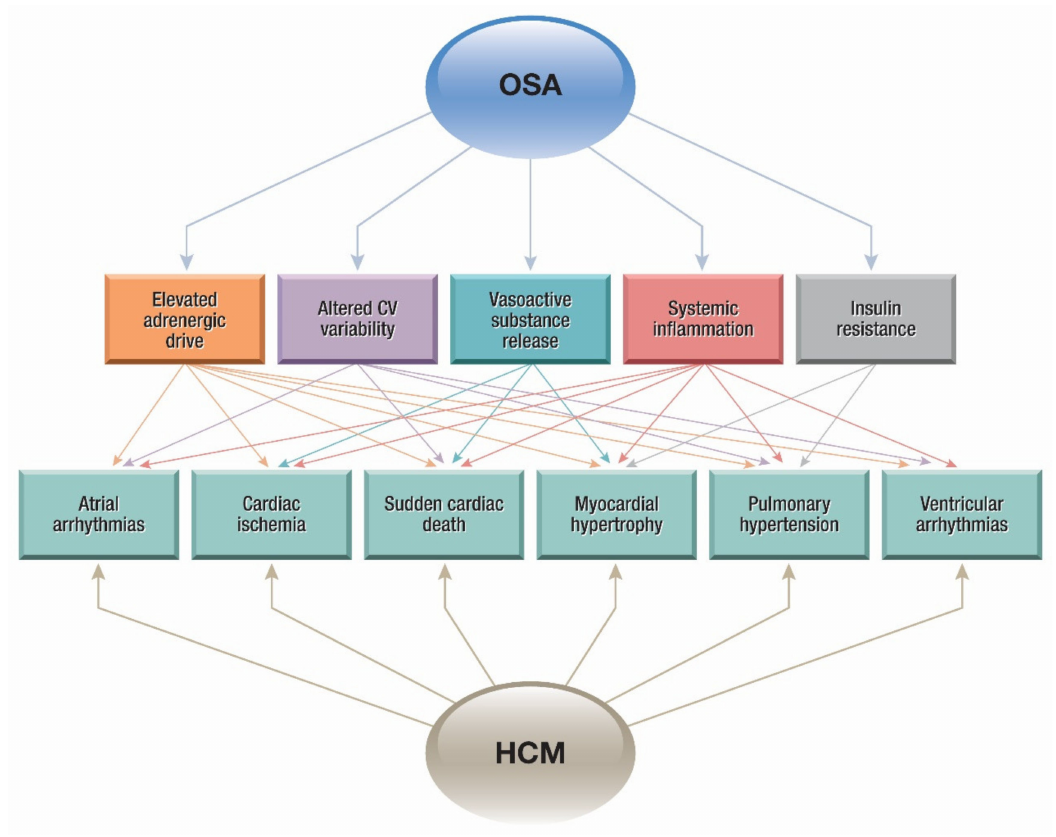
Figure 2. Pathophysiological interaction between obstructive sleep apnea (OSA) and